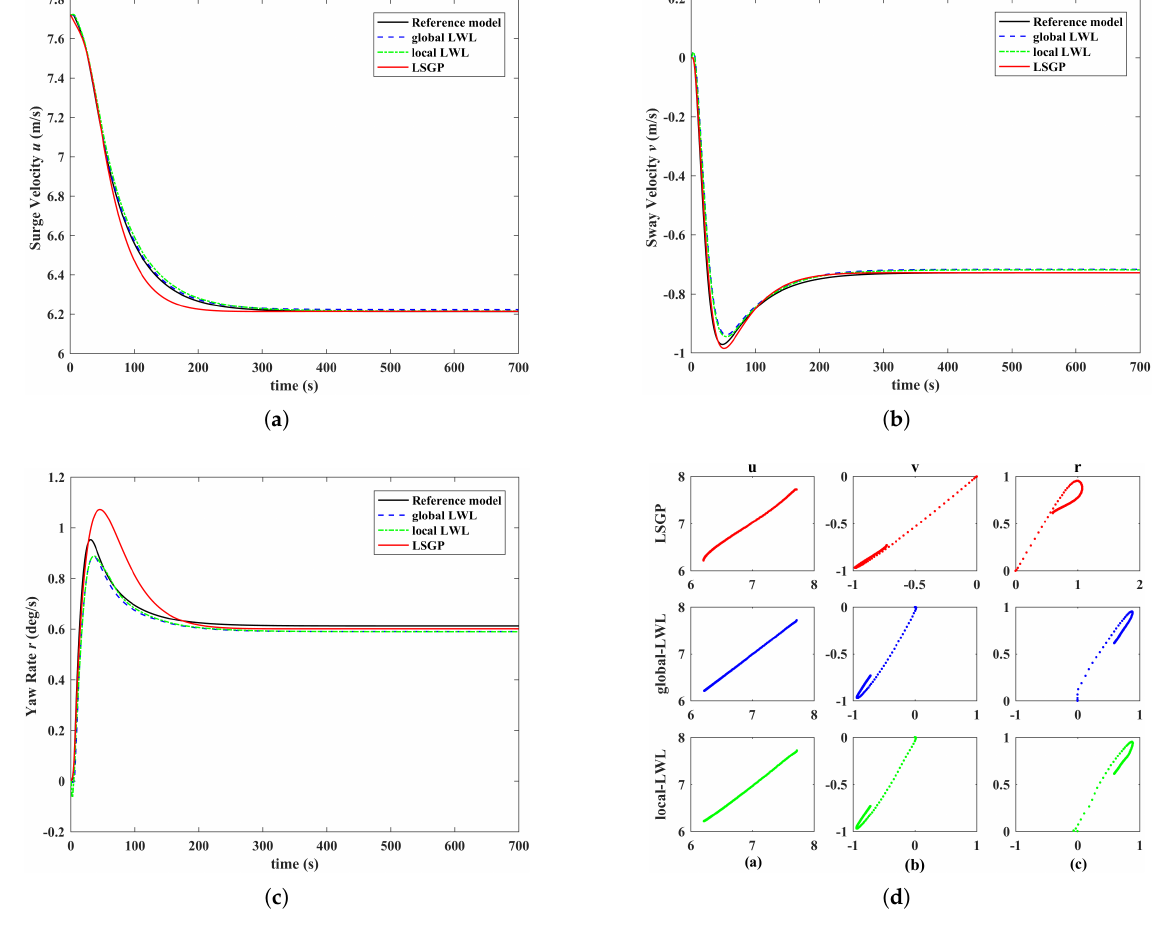
Figure 9. Comparison results of ship motion states for the simulated T-25 ◦ test. It shows the changes of the ship’s motion state on the three degrees of freedom, ( a ) is the Surge Velocity, ( b ) is the Sway Velocity, and ( c ) is the Yaw rate. ( d ) Scatter plot of simulation prediction and reference model, the abscissa is simulation prediction, and the ordinate is reference model in each